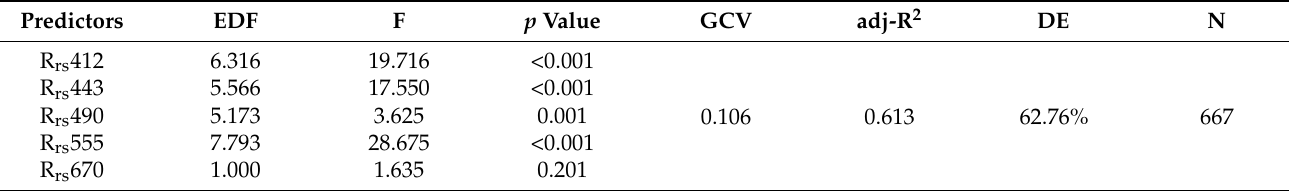
Table 8. Statistical summary of the fitted chrysophytes